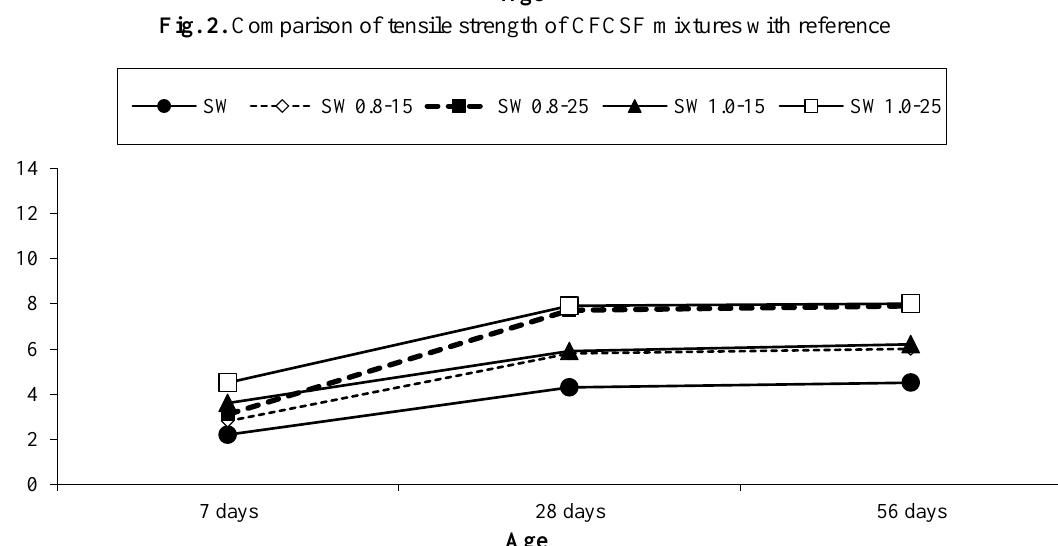
Fig. 3. Comparison of flexural strength in CFCSF mixtures with